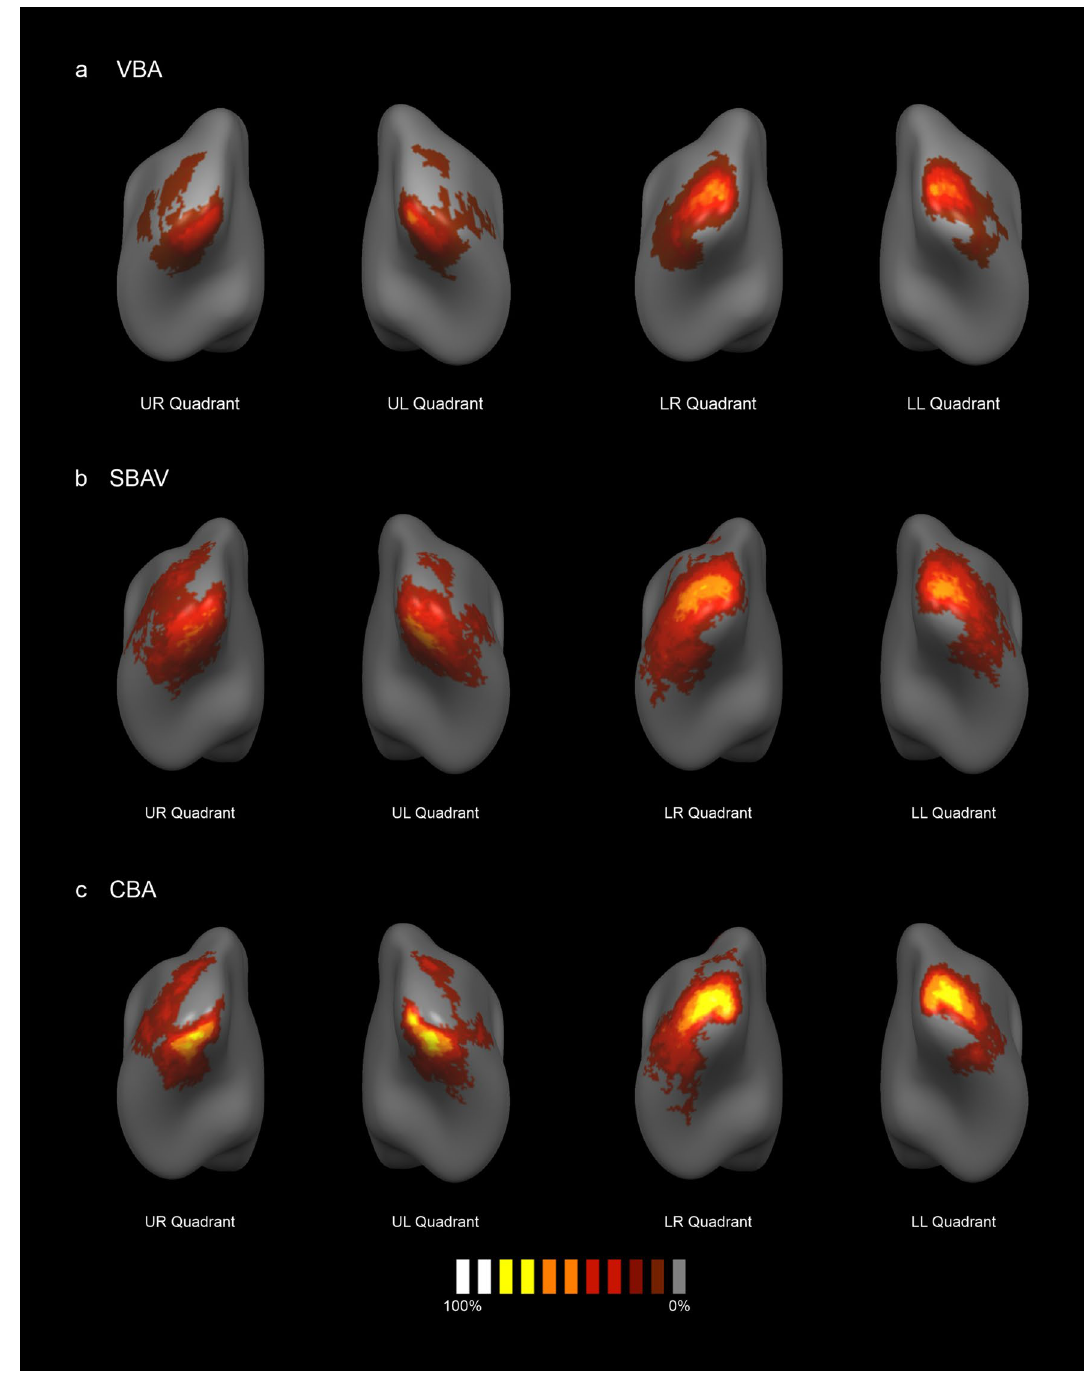
Figure 2. Probability maps (PMs). PMs indicating the probability of activation overlap across subjects for each visual quadrant. The color code gray-to-white indicates the probability of activation overlap of single-subject maps, thresholded at a minimum of 10% probability of activation overlap. Single-subject maps were thresholded at p < 0.05 (uncorr.). We also applied a cluster level threshold of 100 vertices. ( a ) PMs for VBA showed a maximum probability of activation overlap of up to 55%. ( b ) PMs for SBAV showed a maximum probability of activation overlap of up to 66%. ( c ) PMs for CBA showed a maximum probability of activation overlap of up to